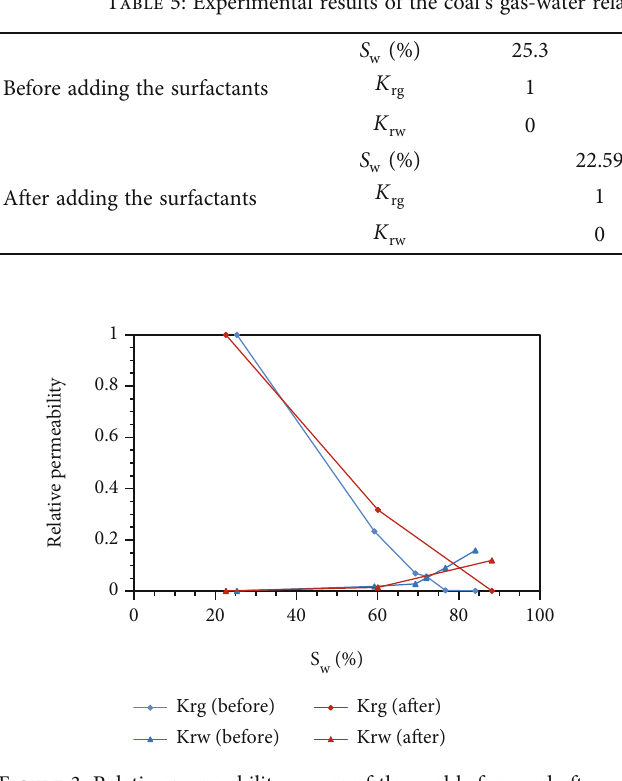
Figure 3: Relative permeability curves of the coal before and after the addition of the